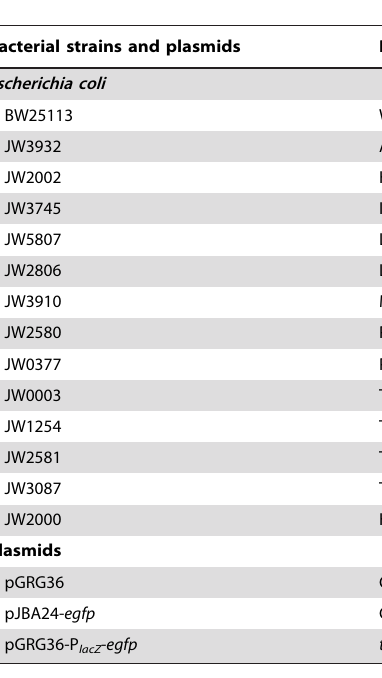
Table 1. Bacterial strains and plasmids used in this study.